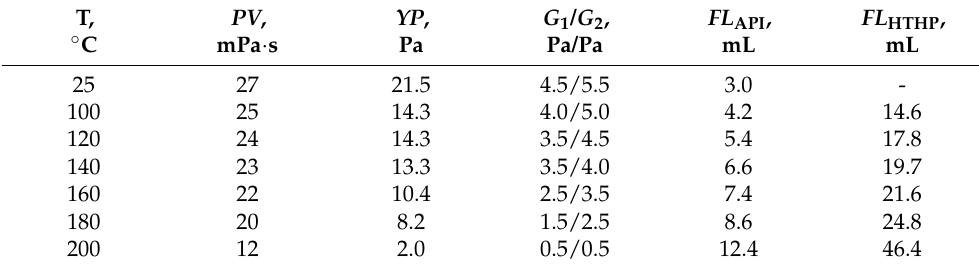
Table 5. Influence of thermal aging temperature on performance of bentonite-free drilling